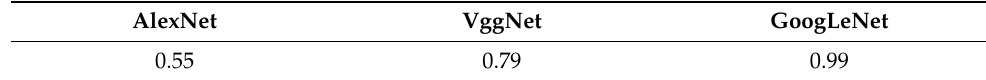
Table 11. AUC comparison under hairstyle